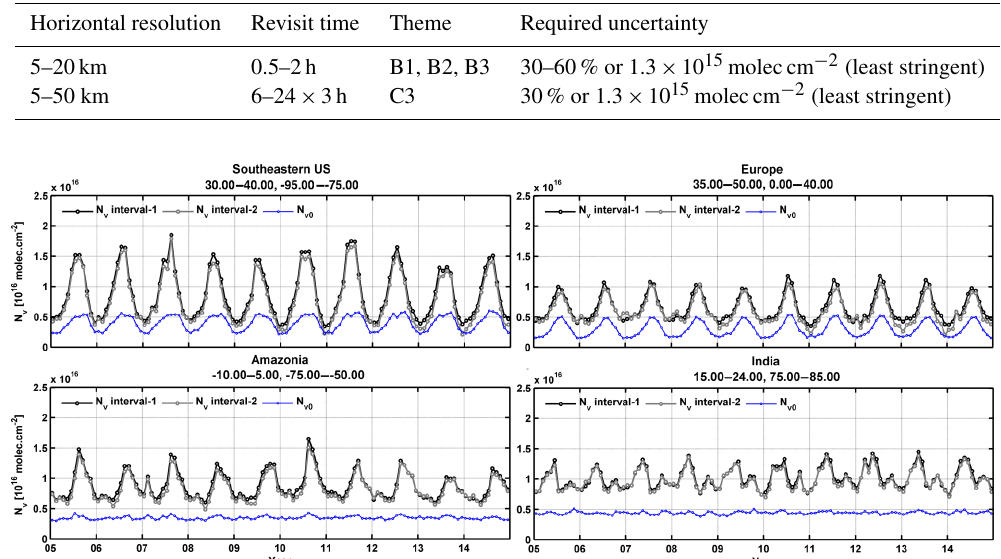
Table 1. Requirements on HCHO vertical tropospheric column products as derived from the COPERNICUS Sentinels 4 and 5 Mission Requirements Document. Where numbers are given as a range, the first is the target requirement and the second is the threshold requirement.